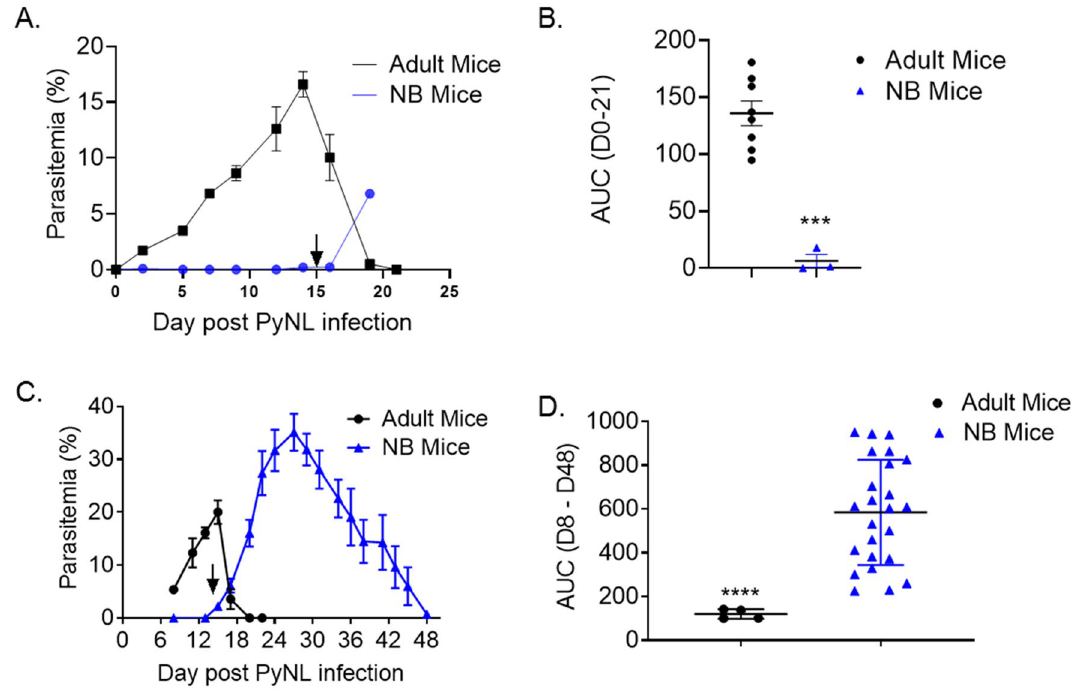
Figure 1. Latency is extended and parasitemia worsened in the NB mice infected with PyNL when compared to adult mice. ( A ) Twenty 6 to 7-days old NB and 8 7- to 8-weeks old adult C57BL/6 mice were infected